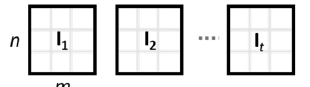
Figure 6. Diagram of matrix structure of the source image.